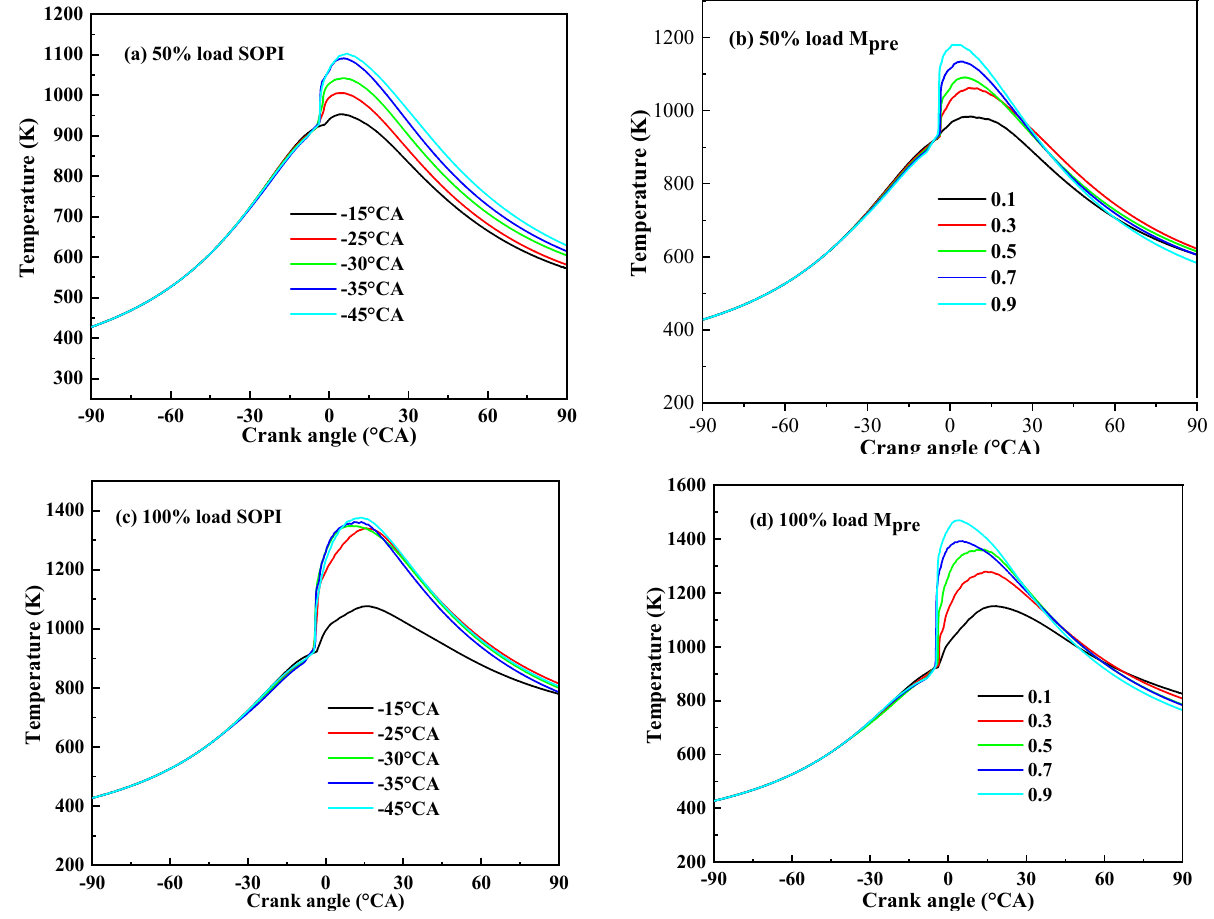
Figure 9. Comparisons of cylinder temperature changes under different load conditions.